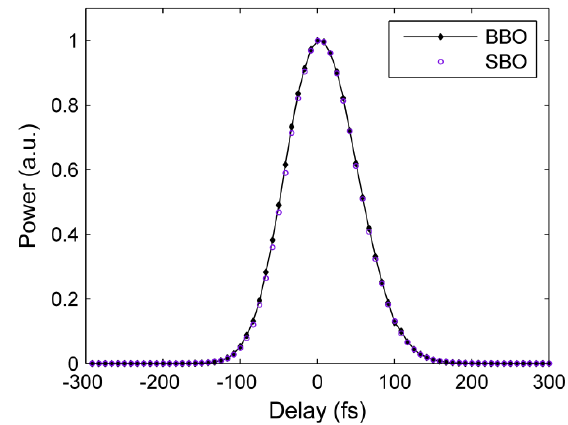
Figure 13. NLDVB autocorrelation trace of Tsunami oscillator measured with NPC SBO (blue) and BBO (black). Central wavelength 840 nm. SBO: pulse duration 75.7 fs; power 5.99 microwatts; SNR-1877; BBO: pulse duration 77.0 fs; power 770 microwatts;